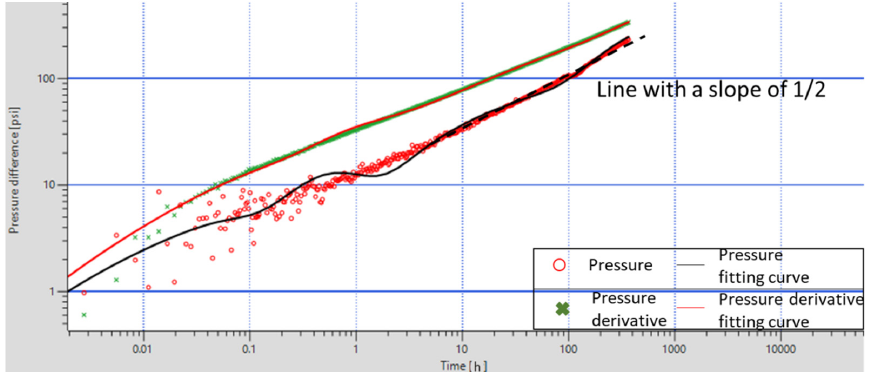
Table 1. Proportion table of well test curves with different characteristics of water injection wells.